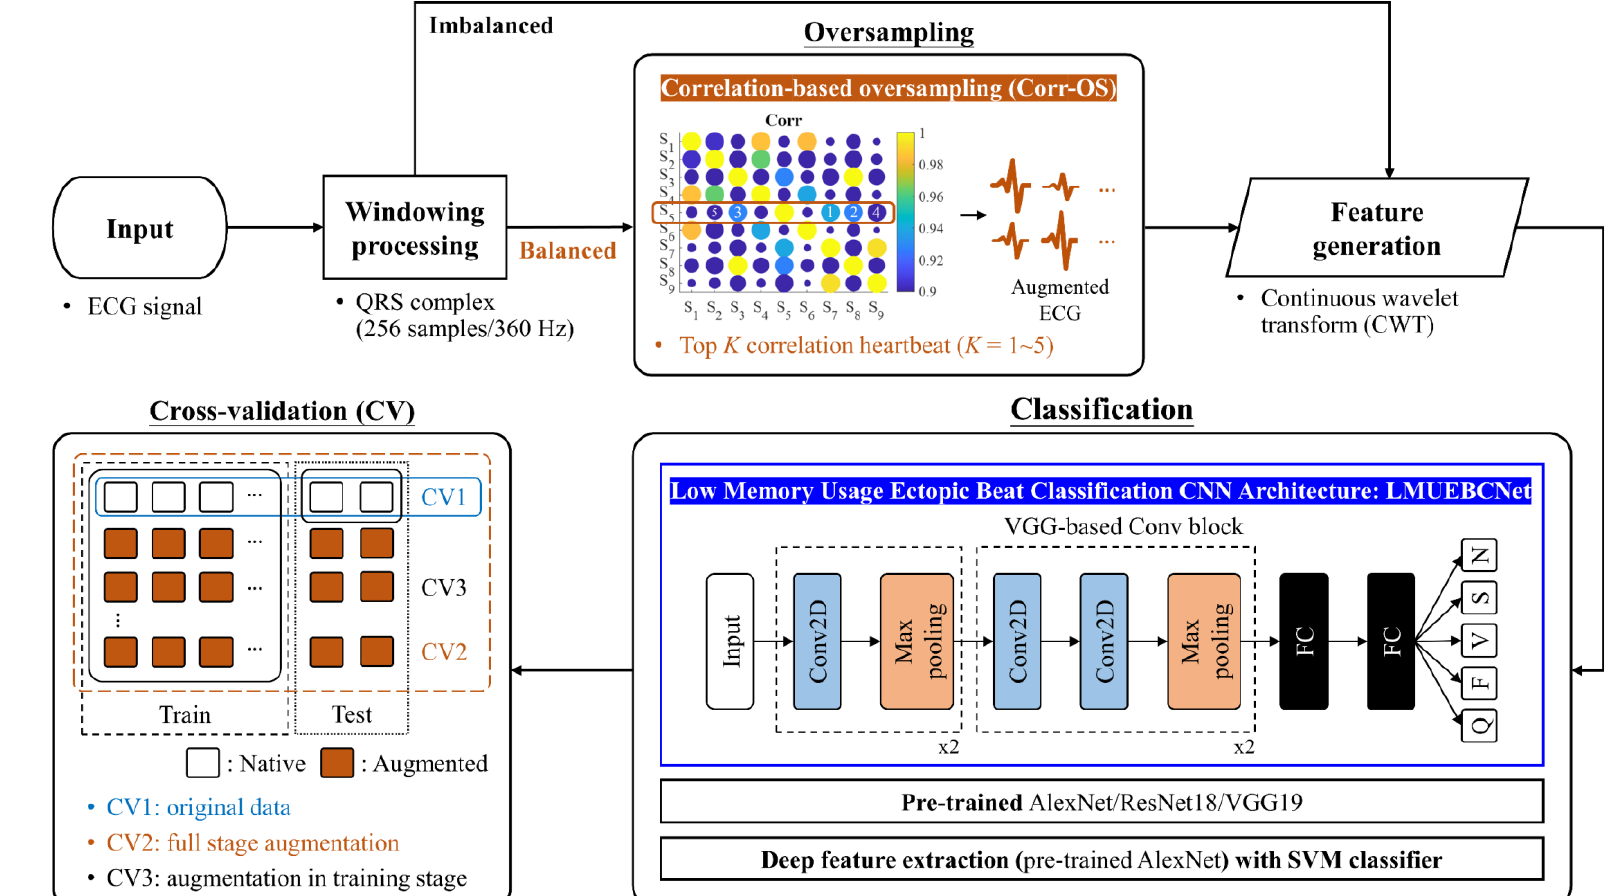
Figure 1. Flowchart of the proposed algorithm.